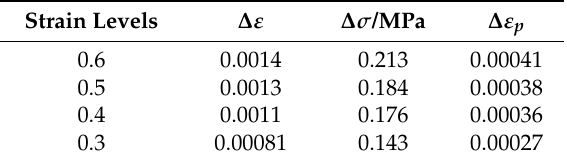
Table 2. True stress amplitude and plastic strain component at different strain levels.